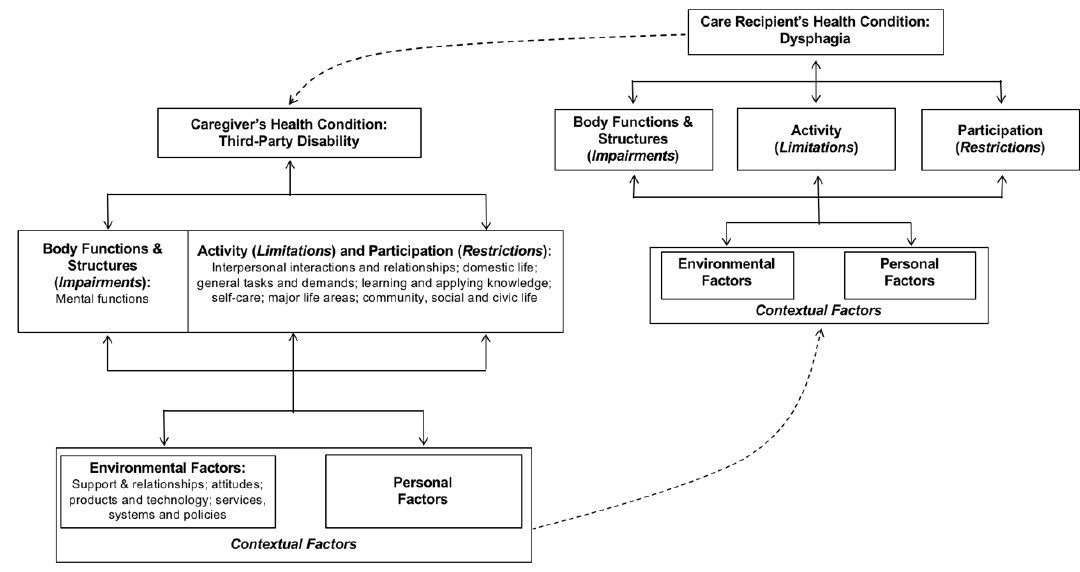
Figure 2. Application of the International Classification of Functioning, Disability, and Health framework [18] to understanding the influence of dysphagia on third-party disability in caregivers, based on the work of Nund and colleagues [14].